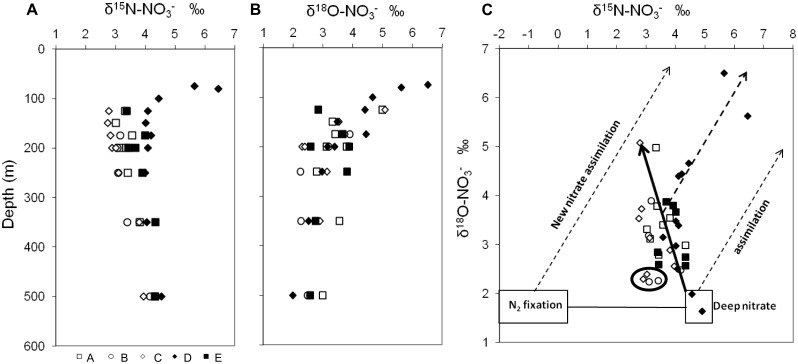
Nitrate N and O isotopic signatures.Nitrate δ15N (A), δ18O (B) depth profiles and relationship between δ18O and δ15N (C): open symbols mark southern stations (A: squares, B: circles, C: diamonds), filled symbols indicate northern stations (D: diamonds, E: squares). Circled data: exceptionally low δ18O and δ15N, respectively indicating low nitrate assimilation and the influence of ‘new’ nitrate derived from N2-fixation, at stations B (250m and 350m) and C (200m).